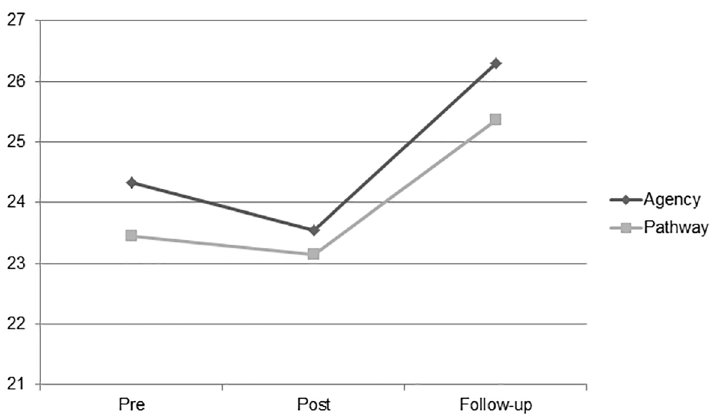
Figure 2. Changes of agency and pathways (Adult Hope Scale) at pre-, post-treatment, and 3-month follow-up